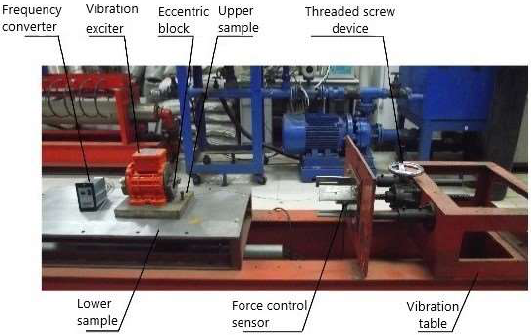
Figure 6. Experimental device picture.